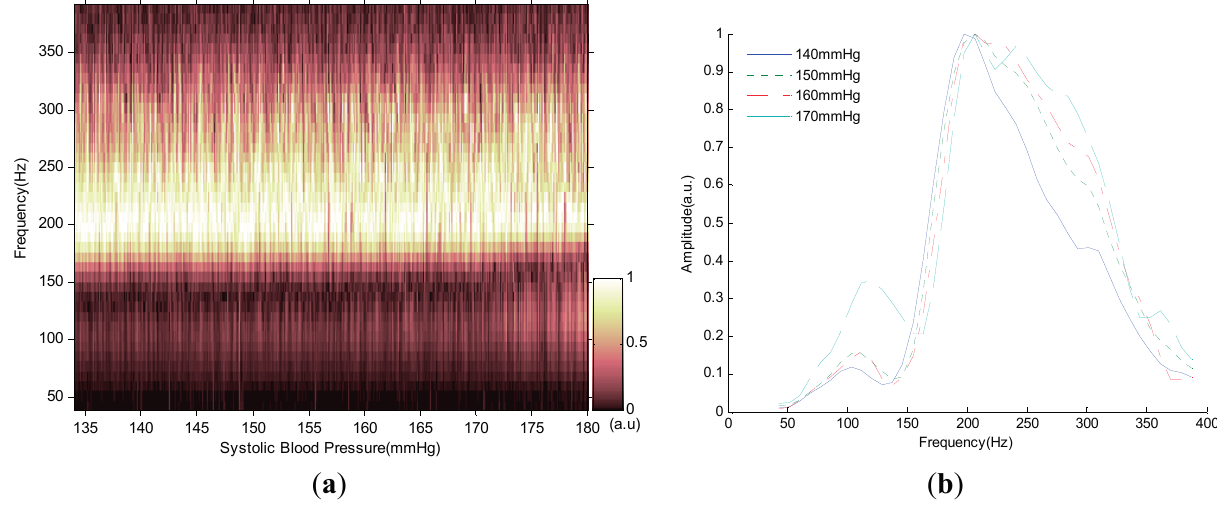
Figure 5. Spectral change of the second heart sound with blood pressure variation. ( a ) Normalized Fourier spectrum of the second heart sound with systolic blood pressure increasing. ( b ) Normalized Fourier spectrum of the second heart sound when the systolic blood pressure was 140, 150, 160 and 170 mmHg.